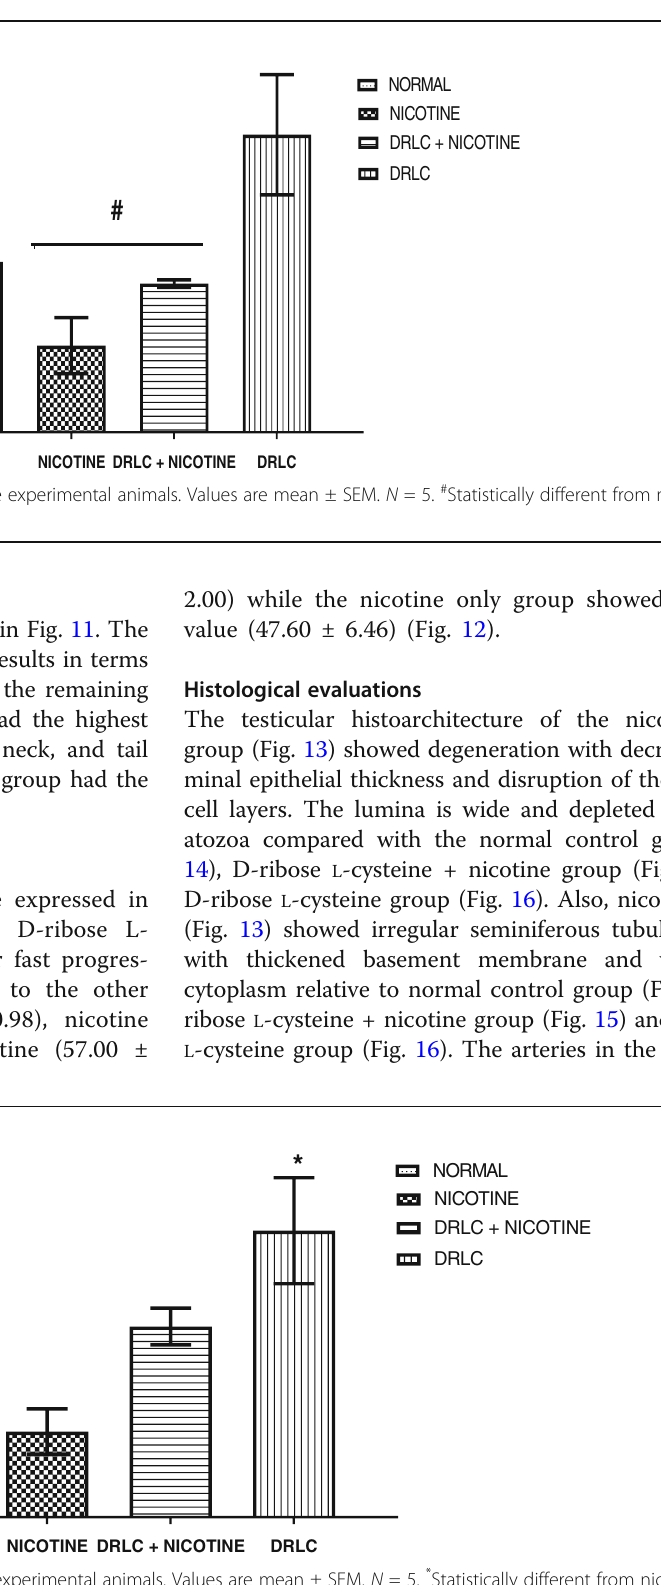
Fig. 9 Chart showing the total sperm count of the experimental animals. Values are mean ± SEM. N = 5. * Statistically different from nicotine group at p <